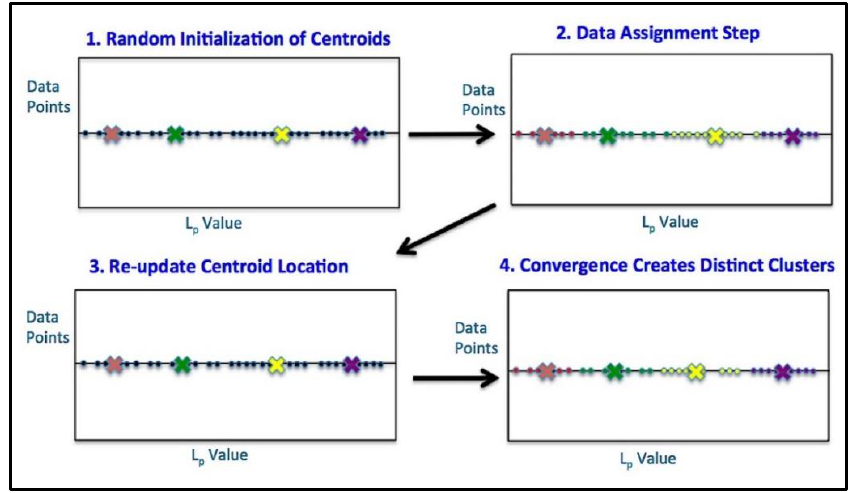
Figure 2. K-means clustering for initial labelling of l p values.